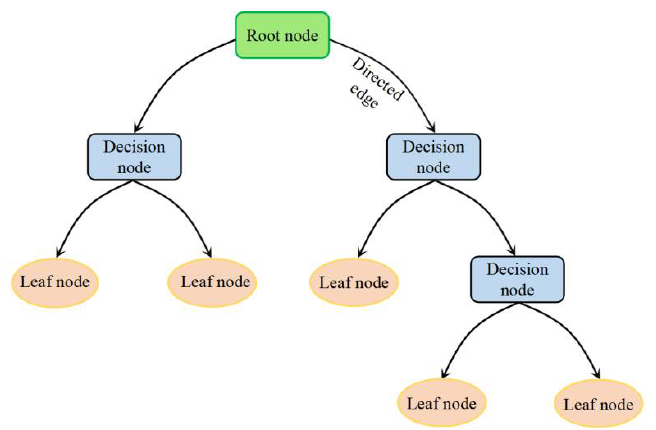
Figure 2. A typical CART